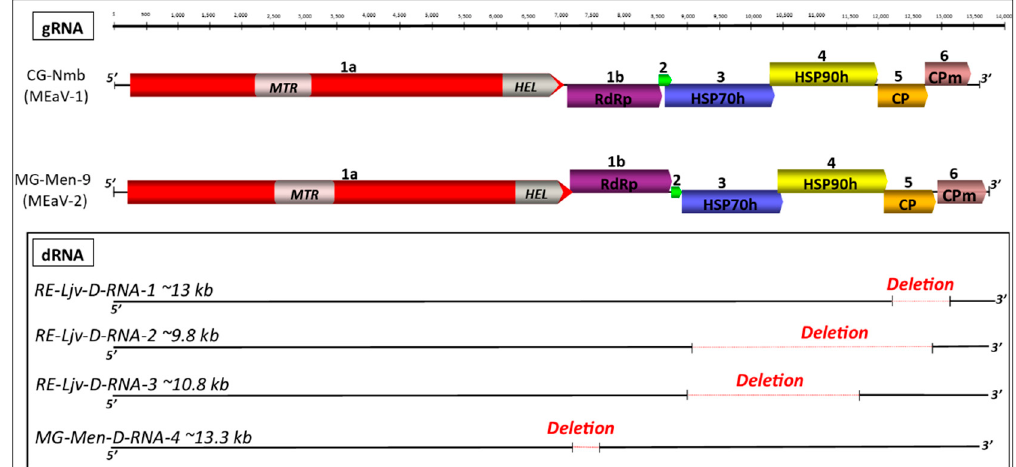
Figure 1. Schematic representation of the genomic organization of representative isolates CG-Nmb (MEaV-1) and MG-Men-9 (MEaV-2) (top) and structure of the defective variants (dRNA) identified (bottom). The RNA genome is drawn as a black line and the predicted open reading frames (ORFs) are represented by colored rectangles. Annotations and ORF numbers are given inside and above rectangles, respectively. Abbreviations: MTR —methyltransferase, HEL —helicase, RdRp —RNA-dependent RNA polymerase, HSP70h —heat shock protein 70 homolog, HSP90h — heat shock protein 90 homolog, CP —coat protein, CPd —minor coat protein. Table 5. Genome length, position of ORFs and size of the encoded proteins for the representative isolates of the two